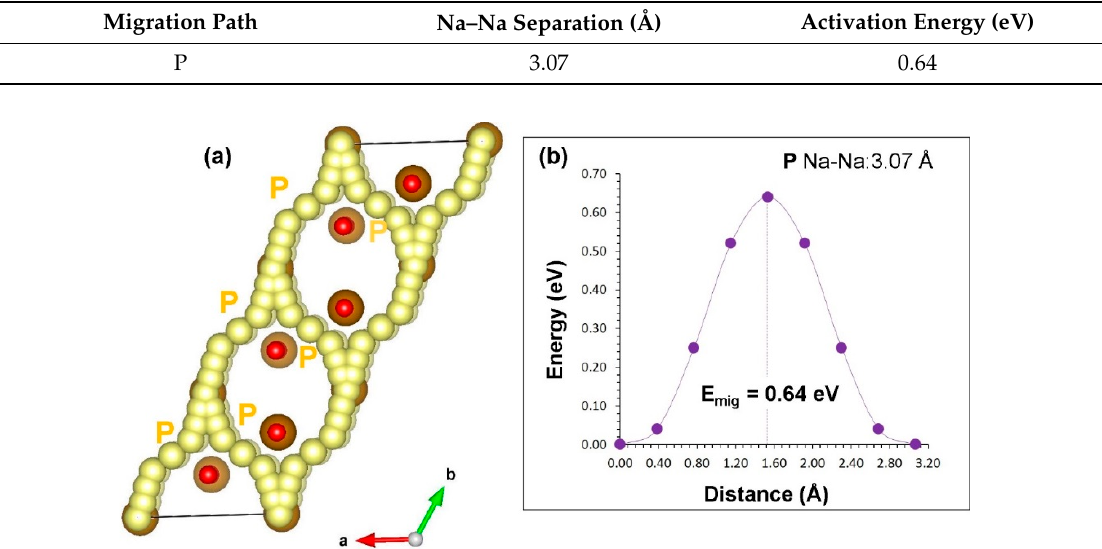
states. The activation energy of migration is defined as the position of the highest potential energy along the migration. Table 2. Calculated Na–Na separation and activation energy for the sodium-ion migration between two adjacent Na sites in α -NaFeO 2 (refer to Figure 3a).